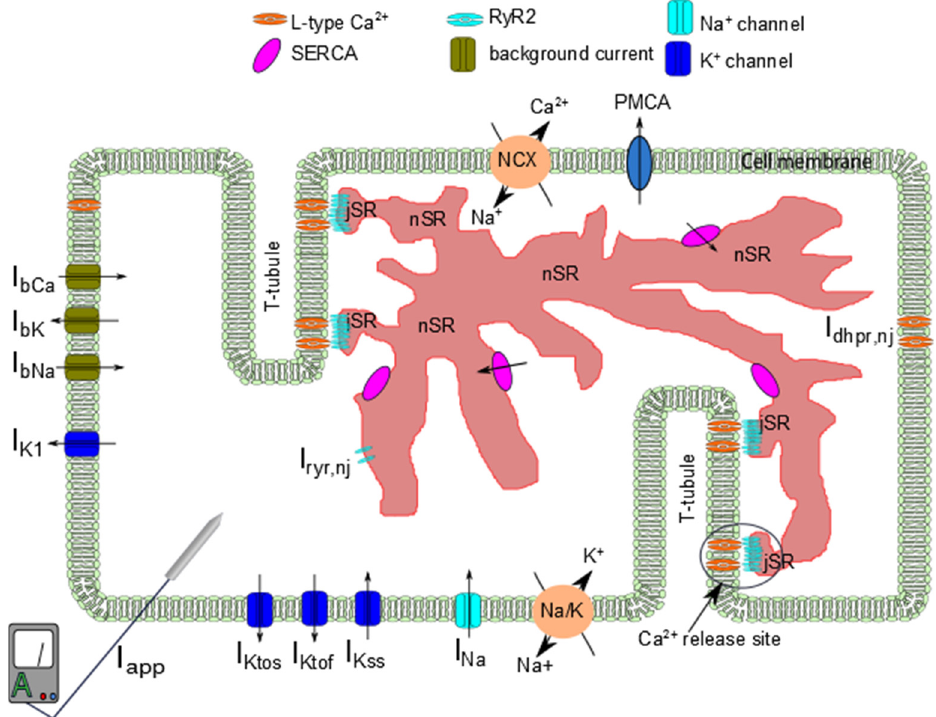
Figure 1. Schematic diagram of a ventricular cell that shows only 2 T-tubule branches with 4 or the 20,000 Ca 2+ release units. Abbreviations: jSR–junctional sarcoplasmic reticulum; nSR–network sar- coplasmic reticulum; ryr–ryanodine receptor; T-tubule–transverse tubule; NCX–sodium-calcium exchanger; Na/K–sodium-potassium ATP ase; PMCA–plasmalemmal calcium ATPase; SERCA–sar- coplasmic and endoplasmic reticulum calcium ATPase; I Na –sodium current; I Kss– steady-state (sus- tained) potassium current; I Ktof –fast transient outward potassium current; I tos –slow transient out- ward potassium current; I K1 –inward rectifier potassium current; I bCa = background calcium current; I bK –background potassium current; I bNa –background sodium current.